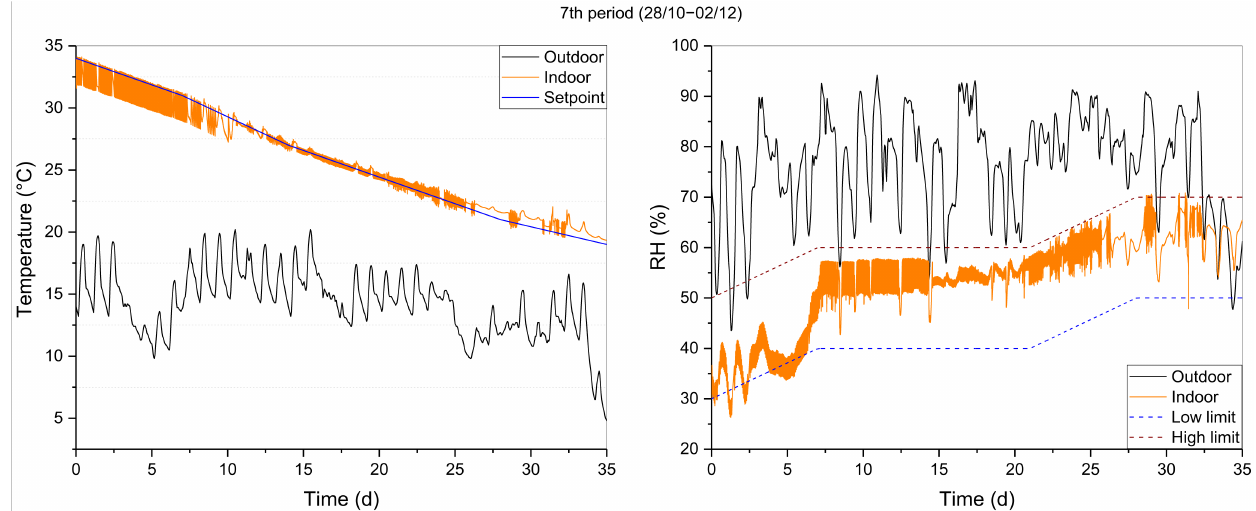
Figure 11. Temperatures and relative humidity variation during the 7th production period